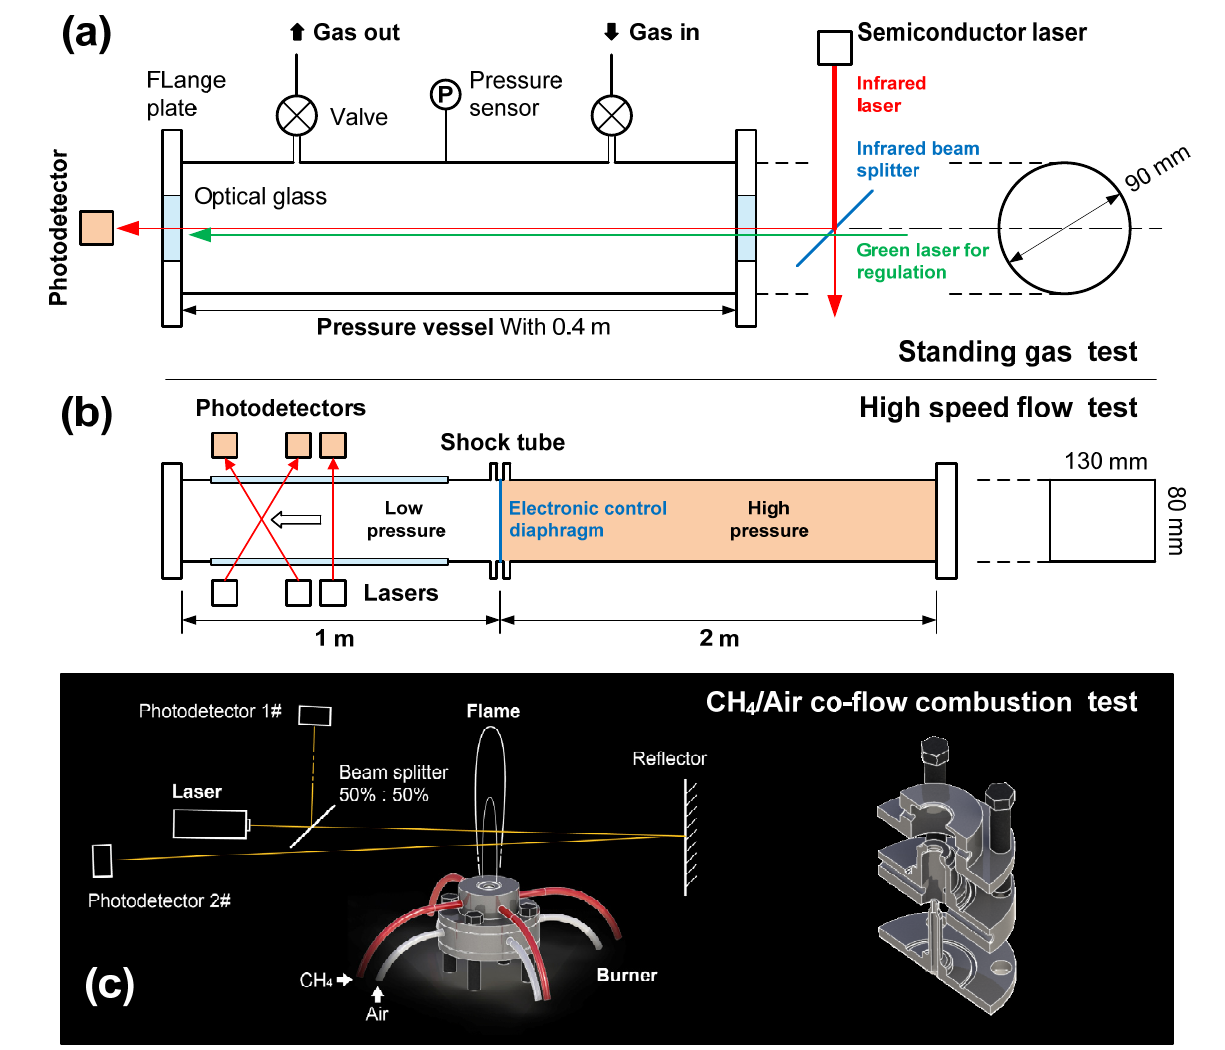
Figure 3. Experimental facilities for TDLAS tests, including ( a ) a pressure vessel, ( b ) a shock tube, and ( c ) a co-flow flame burner.